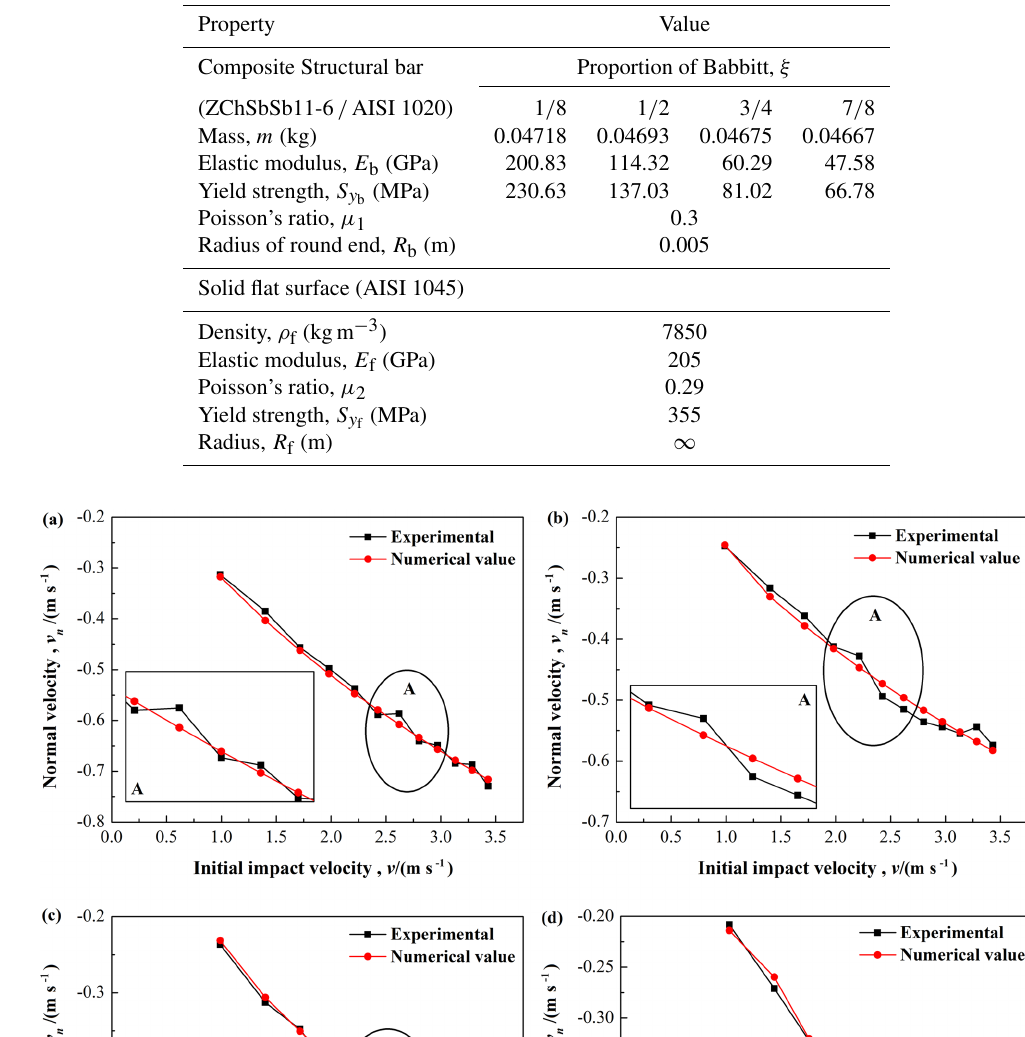
Table 2. The material properties of the composite structural bar and the solid flat surface.